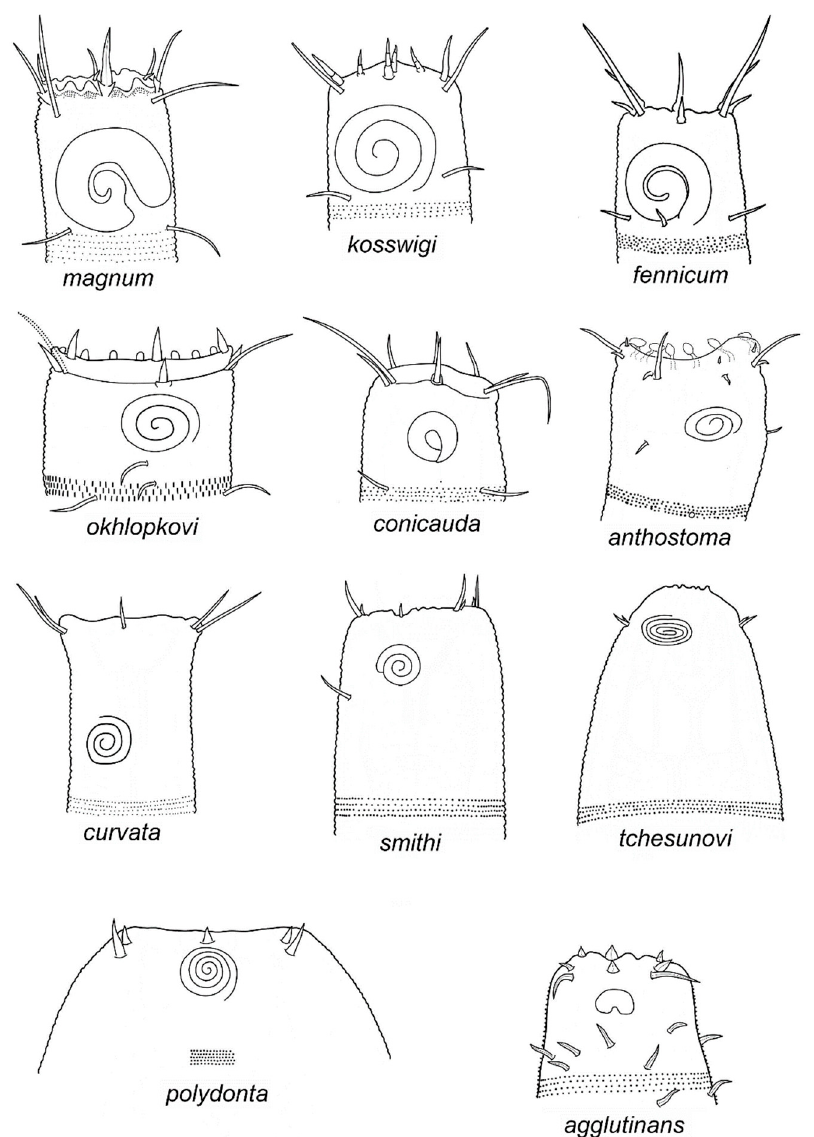
Figure 2. Caricatured male heads of valid Gammanema species arranged from top left to bottom right along decrease of amphid size and cephalic setae in relation to head diameter.